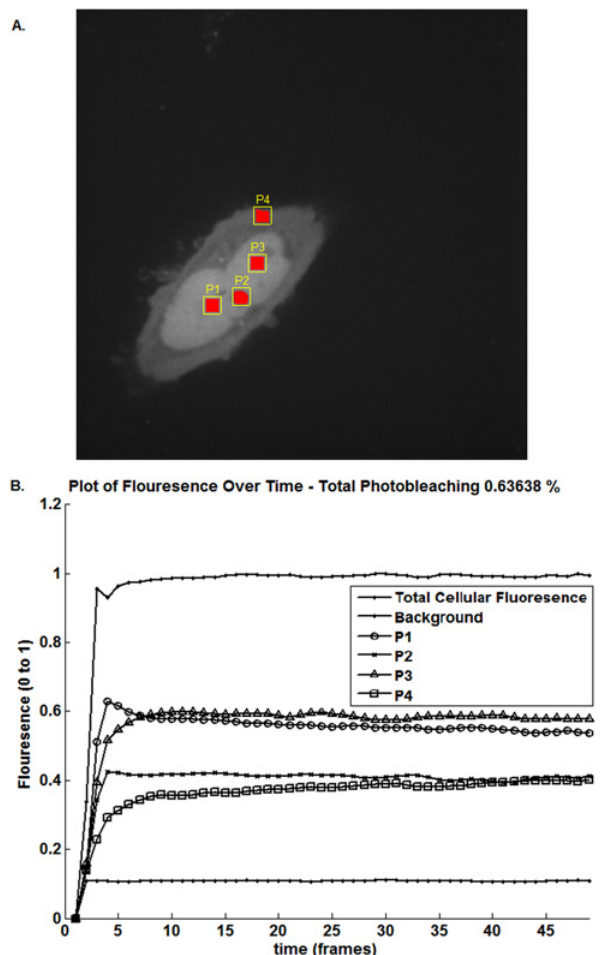
Fig 6. Automated analysis of Dendra2 sub-cellular trafficking in HeLa cells. (A) User defined cellular ROIs using the seeded region growing algorithm. P1 is the PC point; P2 is a distant nucleoplasm region; P3 is a nucleolus and P4 is a region of cytoplasm. (B) Quantification of photo-converted Dendra2 fluorescence in user defined ROIs over